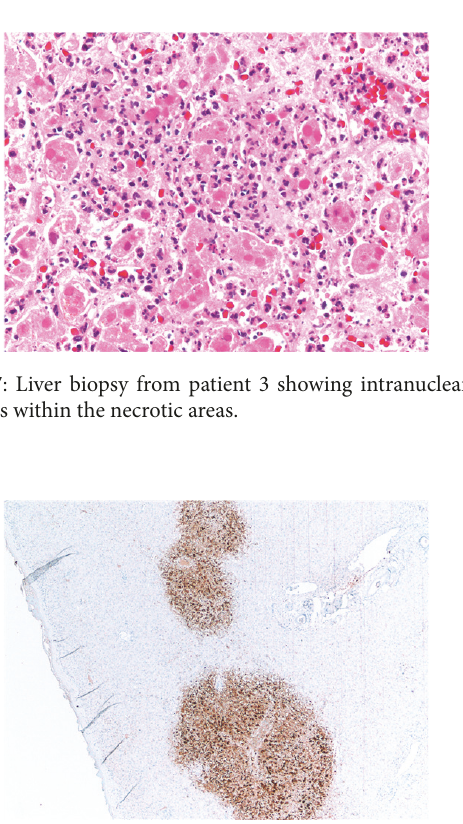
Figure 8: HSV immunostain from liver biopsy (patient